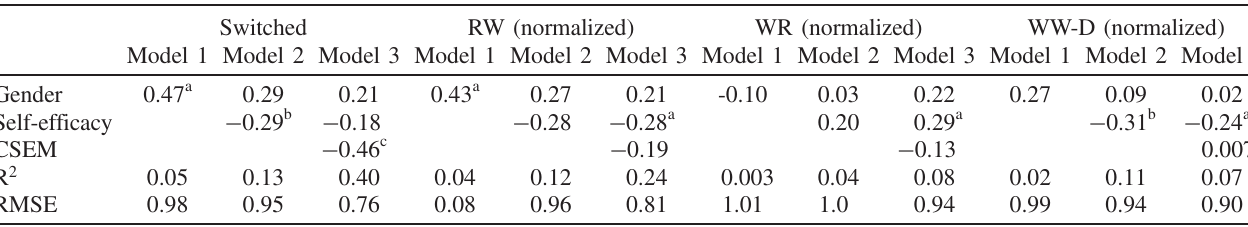
TABLE II. Standardized coefficients for linear regression models predicting proportion of responses: switched out of all responses (switched), switched from right to wrong out of all correct responses in the first round (RW normalized), switched from wrong to right out of all incorrect responses in the first round (WR normalized), and switched from wrong to a different wrong out of all incorrect responses in the first round (WW-D normalized). Model 1 controls for gender, model 2 controls for gender and precourse student self-efficacy, and model 3 controls for gender and both pre-course student self-efficacy and CSEM scores. Switched RW (normalized) WR (normalized) WW-D (normalized)